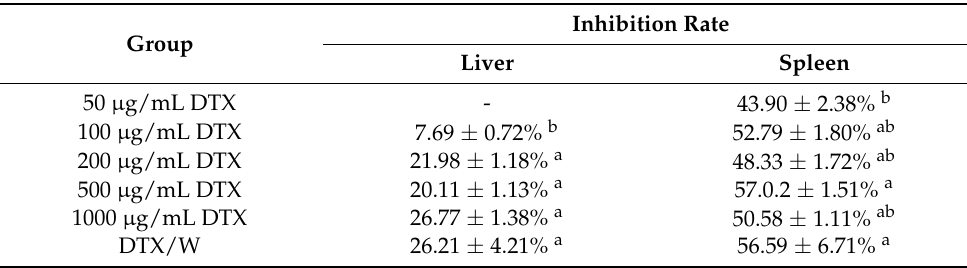
Table 5. Inhibition rates of MDA production by DTX and DTX/W-containing emulsions in different tissue